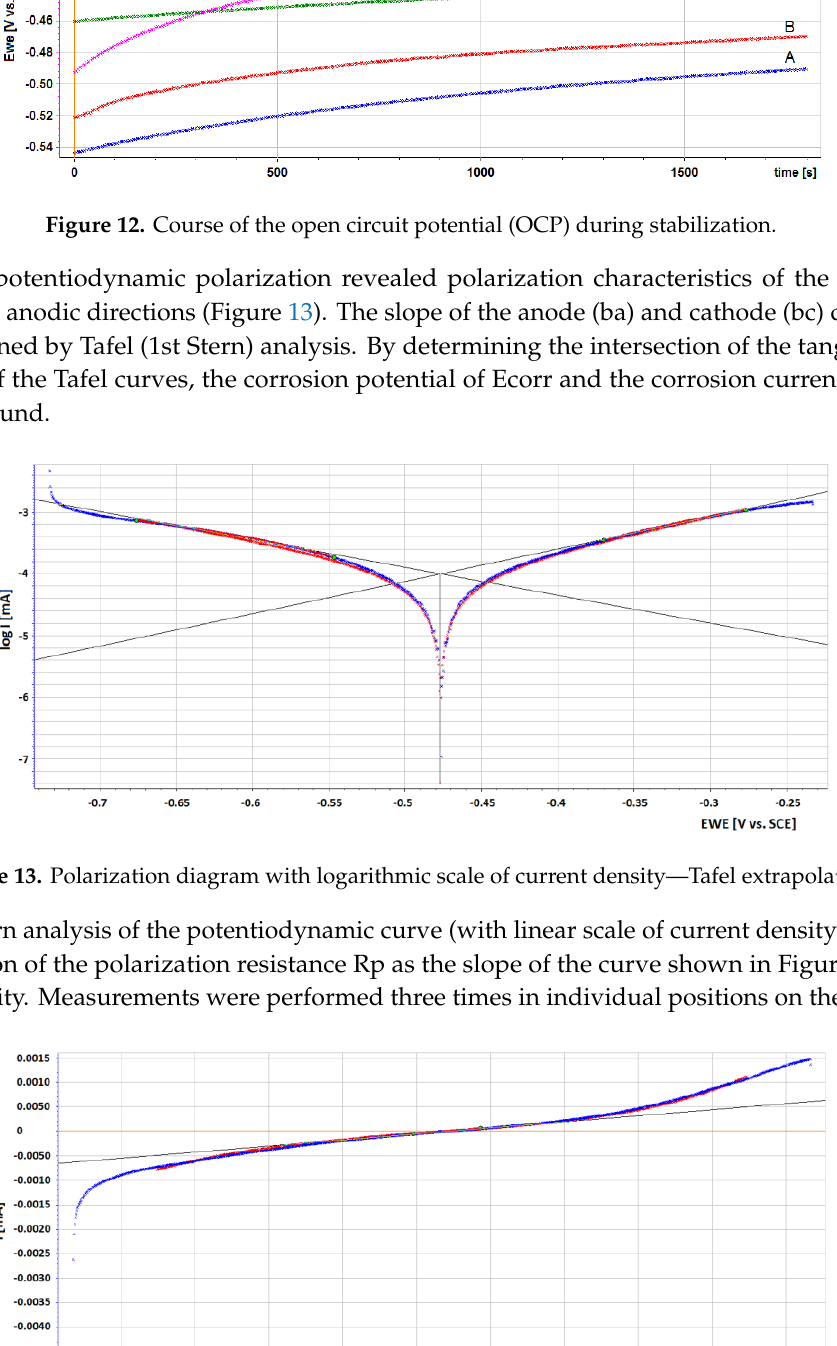
Figure 14. Polarization diagram with linear scale of current density—determination of Rp.